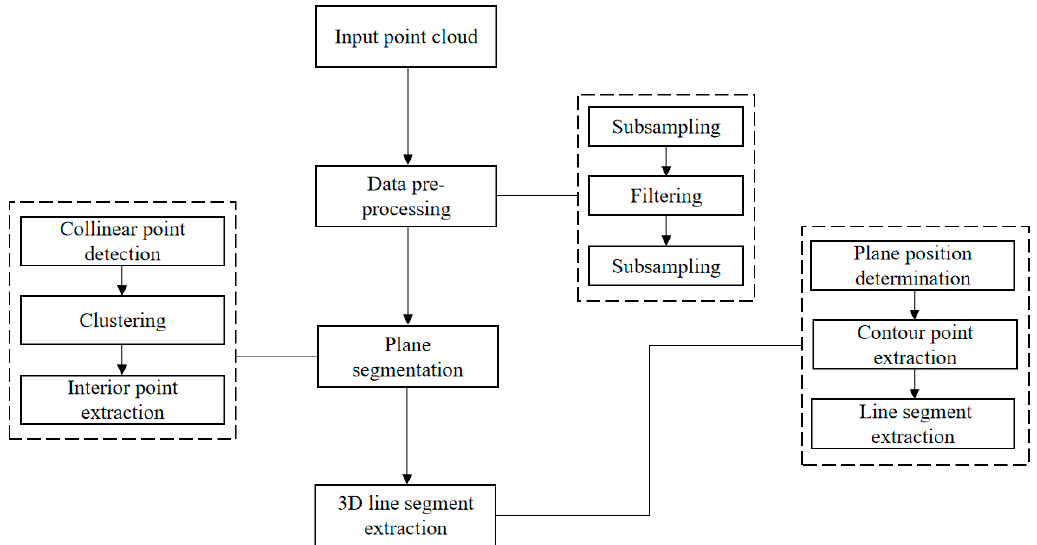
Figure 1. Overall flow of the proposed 3D line segment feature extraction method.